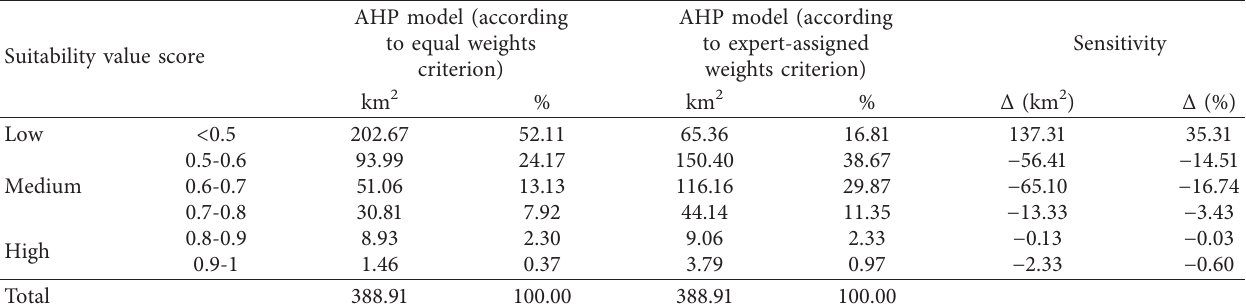
Table 7: Solar sensitivity analysis results.